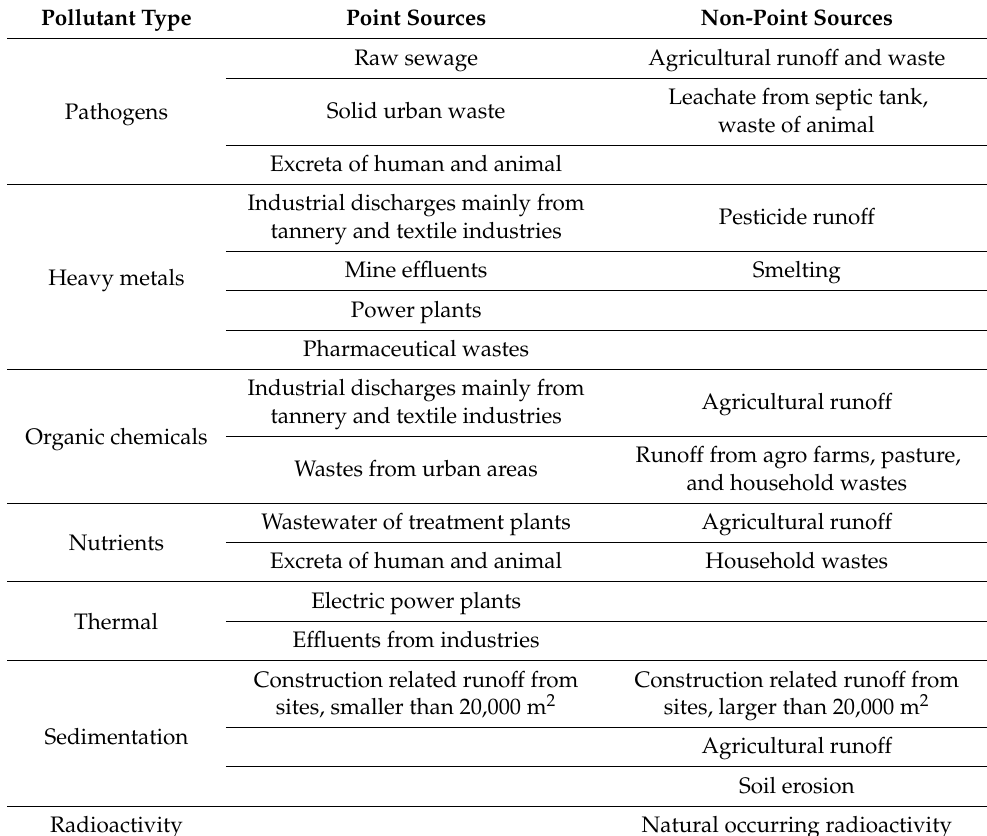
Table 4. Sources of water pollution in inland waters of